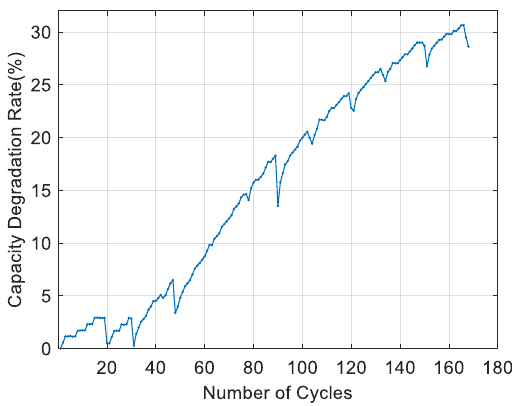
Figure 1. Capacity degradation rate curve of No. 5 battery.